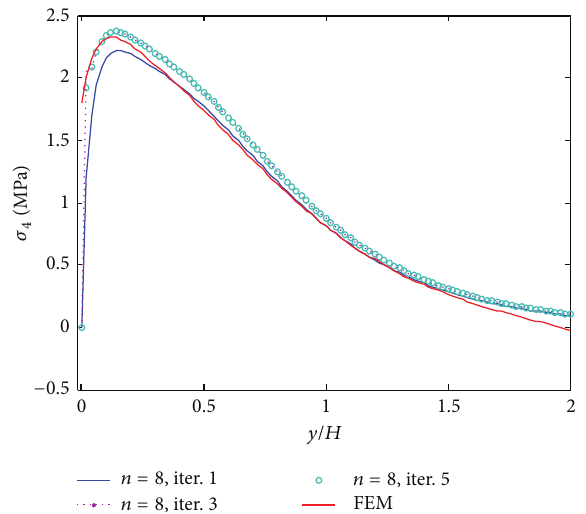
Figure 5: 𝜎 4 distribution of [PZT/0 4 /90 4 ]s laminate at the interface of 𝑧/𝐻 = 1/6 from different iterations, under 0.1% uniaxial